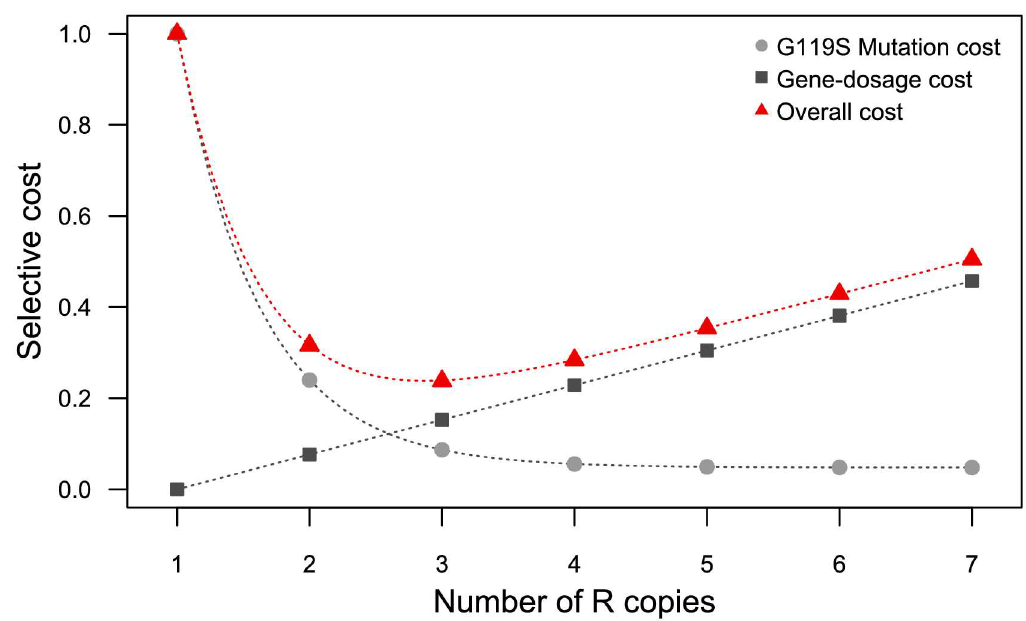
Fig 5. Hypothetical model to explain the non-monotonous relationship between fitness cost and the number of R copies, and the minimum cost centered on three copies per chromosome. Under this hypothesis,the overall fitness cost (red triangles)is the result of two oppositefunctions: the cost associated with G119S mutation (light gray circles) and the cost due to the changein gene dosage(dark gray squares). The first of these costs is negatively correlatedwith the number of R copies. Thus, larger numbers of R copies are associatedwith lower costs. By contrast, the second cost is positivelycorrelated with the numberof R copies. Note that the shapes of each function and their interactionare